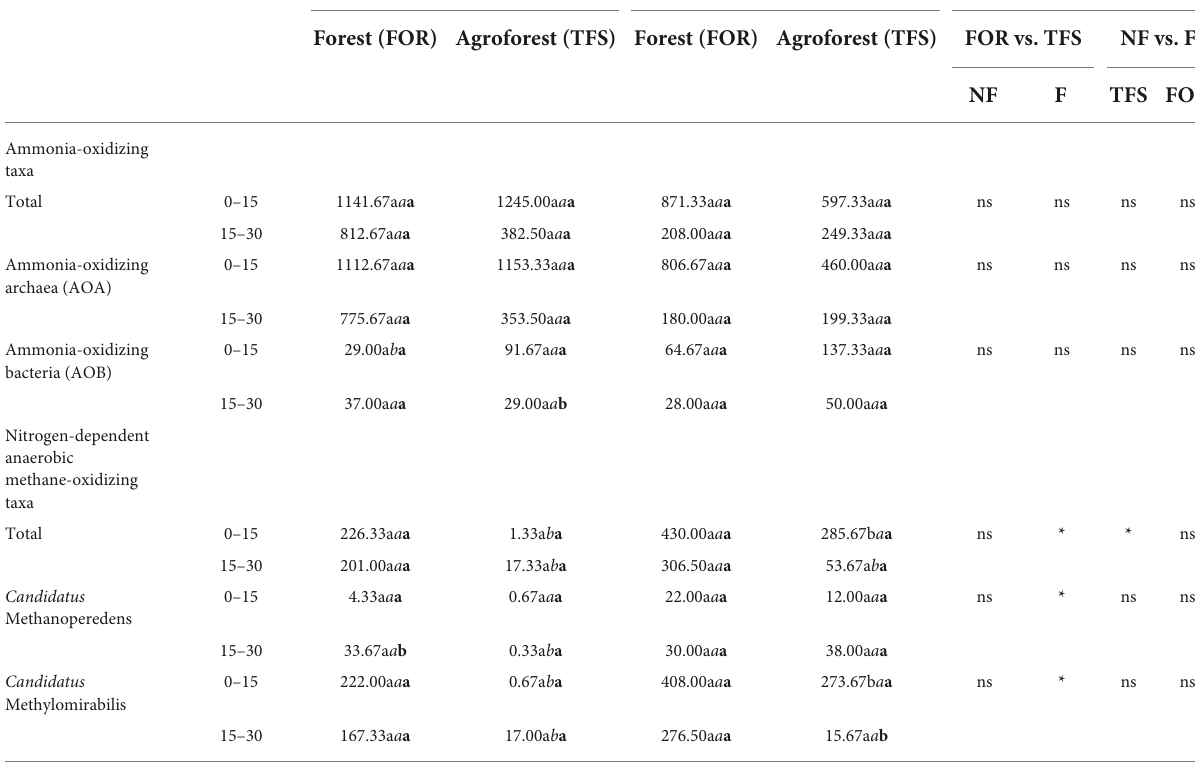
TABLE 3 Absolute sequence abundance of active ammonia-oxidizing and anaerobic methane-oxidizing bacteria and archaea in each depth, site, and season in the Tocantins River plain based on 16S rRNA gene amplicon sequencing data. Microbial group Depth (cm) Non-flood Flood Statistics Forest (FOR) Agroforest (TFS) Forest (FOR) Agroforest (TFS) FOR vs. TFS NF vs. F NF F TFS